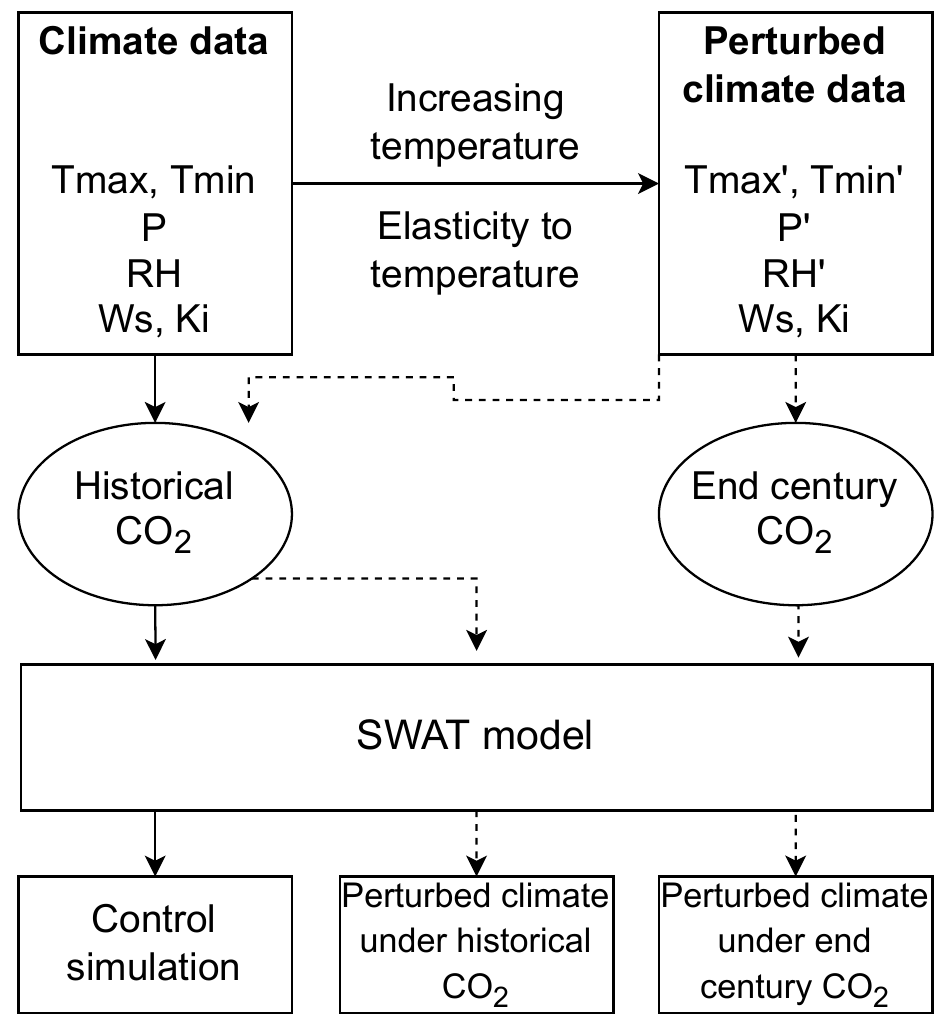
Figure 4. Flowchart of the experiment design. Abbreviations Tmax, Tmin, P, RH, Ws, and Ki refer to maximum air temperature, minimum air temperature, relative humidity, wind speed, and incoming solar